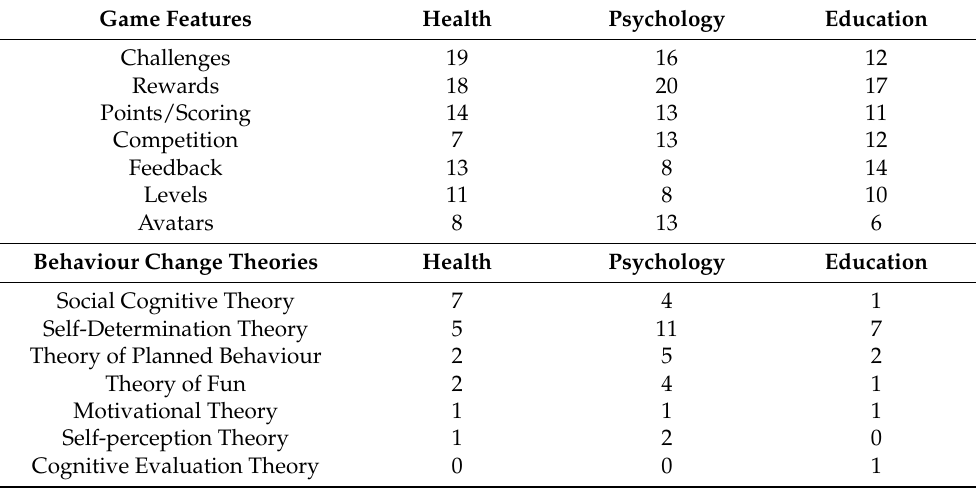
Table 3. Frequency of game features and behaviour change theories among the